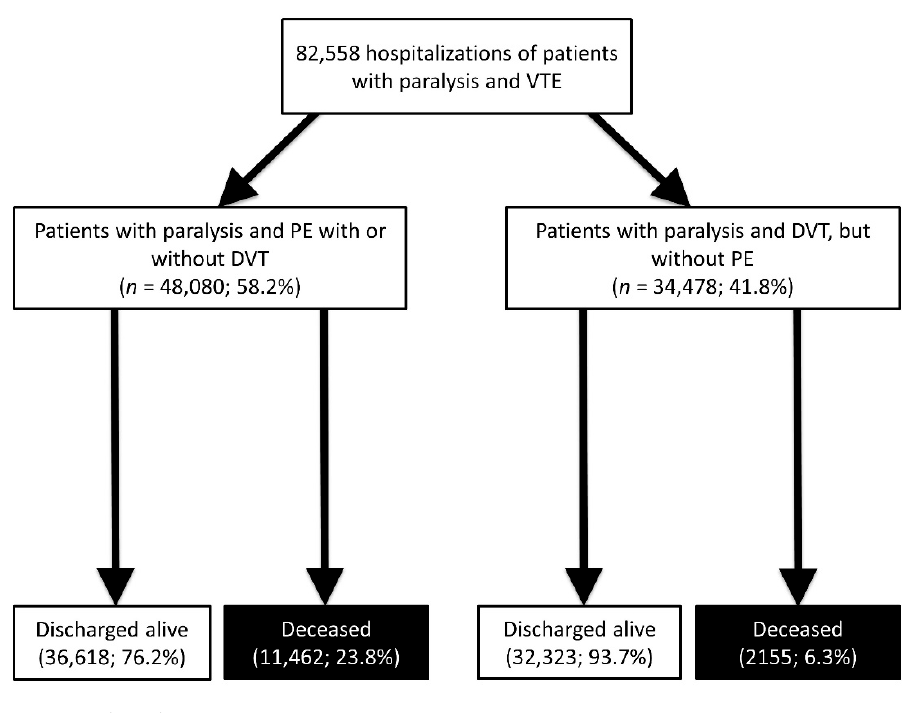
Figure 1. Flow Figure 1. Flow diagram.